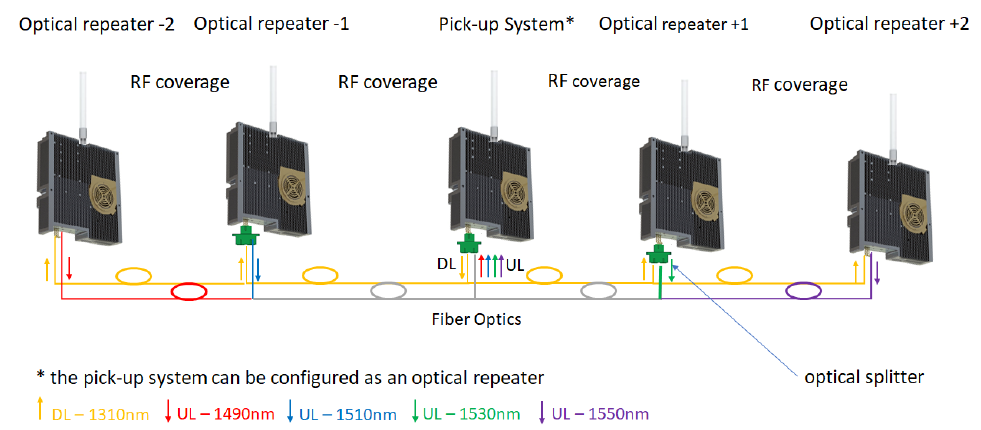
Figure 1. High level architecture for a cluster of 5 optical repeaters.